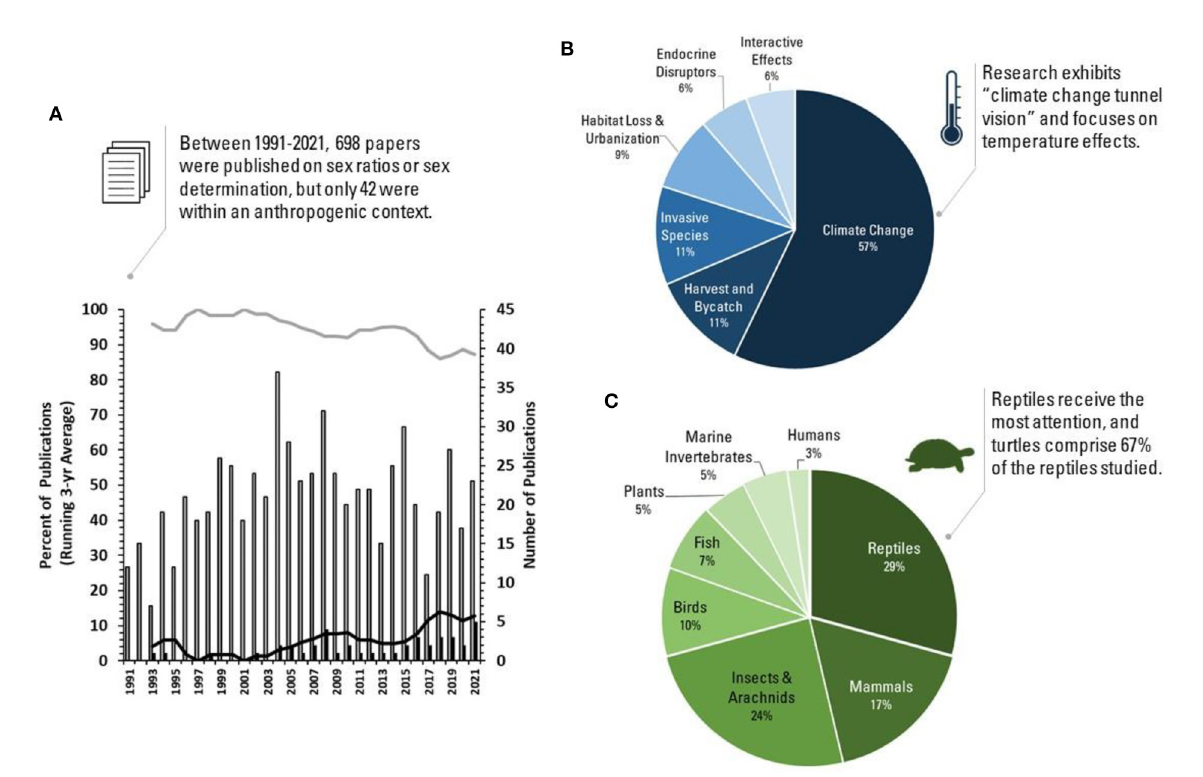
FIGURE1 Publishing trends from top tier journals (Science, Nature, Proceedings of the Royal Society: B, Proceedings of the National Academy of Sciences of the USA, and Current Biology) between 1991- and 2021 on anthropogenic disturbances to sex ratios or sex determination based on the Web of Science database. (A) The number of papers published annually on sex ratios or sex determination in a fundamental context (gray bars) versus. an applied context (black bars). Trend lines are 3-year moving averages on the percentage of sex ratio or sex determination papers each year that were fundamental (gray) versus applied (black). (B) The anthropogenic threats studied within the applied sex ratio or sex determination papers. (C) The taxa represented in the applied sex ratio or sex determination research. Because we were concerned that using the above journals might bias our results toward fundamental studies, we ran a second literature analysis using eight top-tier conservation journals. Research in these journals emphasized applied sex ratio or sex determination research, yet produced strikingly similar trends and publication biases (unpublished) to the above